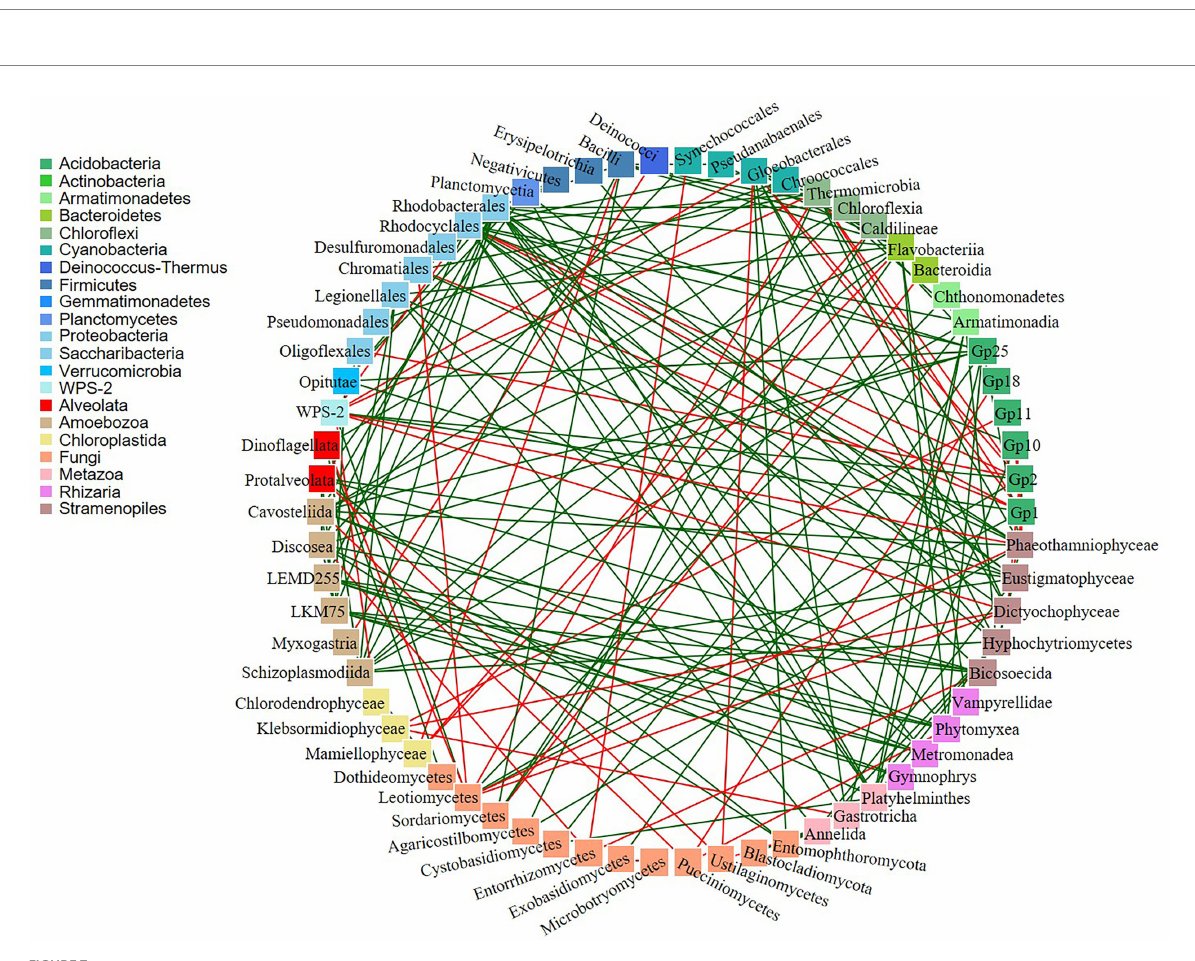
FIGURE 7 Co-occurrence networks of bacteria and eukaryotes. Green and red lines indicate positive and negative correlations,